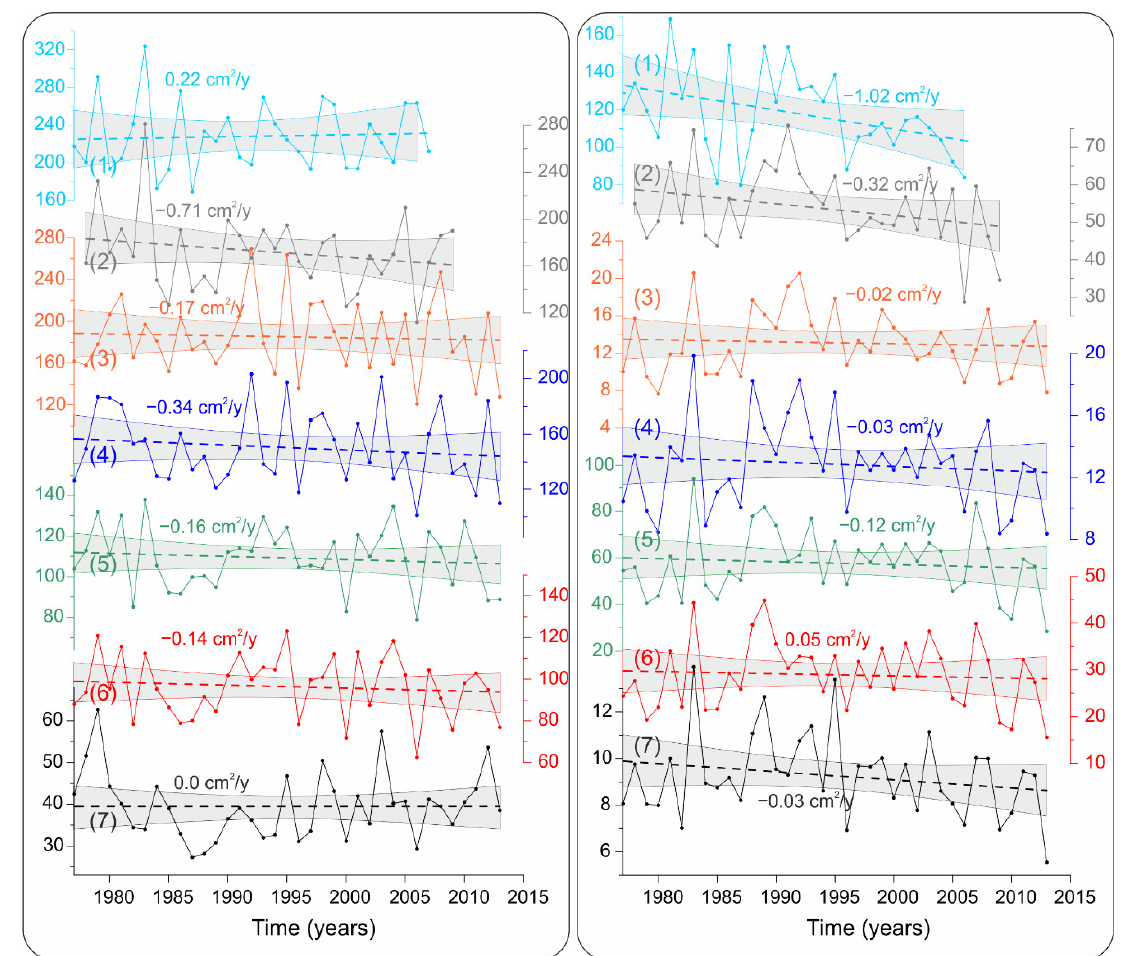
Figure 9. Interannual variability of the synoptic (left) and mesoscale (right) Baltic Sea level oscillation variance for the period from 1977 (1978) to 2013 (2007, 2009) at stations (1) Gorny Institute, (2) Pärnu, (3) Ratan, (4) Furuogrund, (5) Klagshamn, (6) Kungsholmsfort, and (7) Stockholm. The dashed line shows multiyear linear trends with 95% confidence intervals (the lighter shaded area).